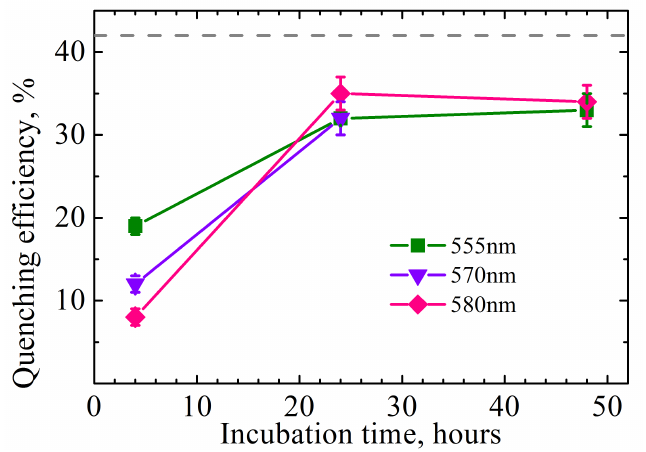
Figure 10. The efficiency of QD PL quenching by SPIONs in cells estimated by the PL decay times measured at 555, 570, and 580 nm, as a function of incubation time (data from Figure 9); the dashed line is PL quenching efficiency in solution (data from Figure